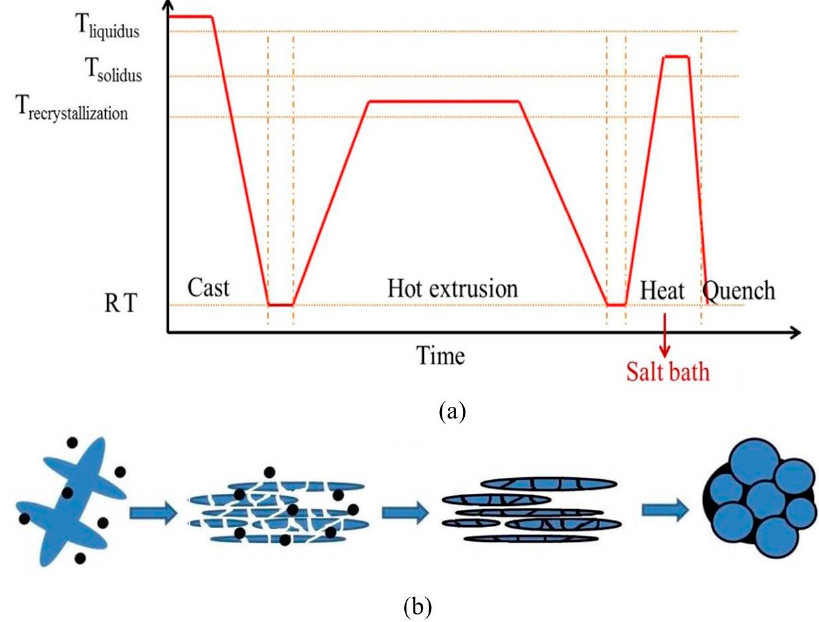
Figure 1. ( a ) Process flow and ( b ) mechanism of grain spheroidization of modified strain-induced melting activation (SIMA) process (RT: room temperature).